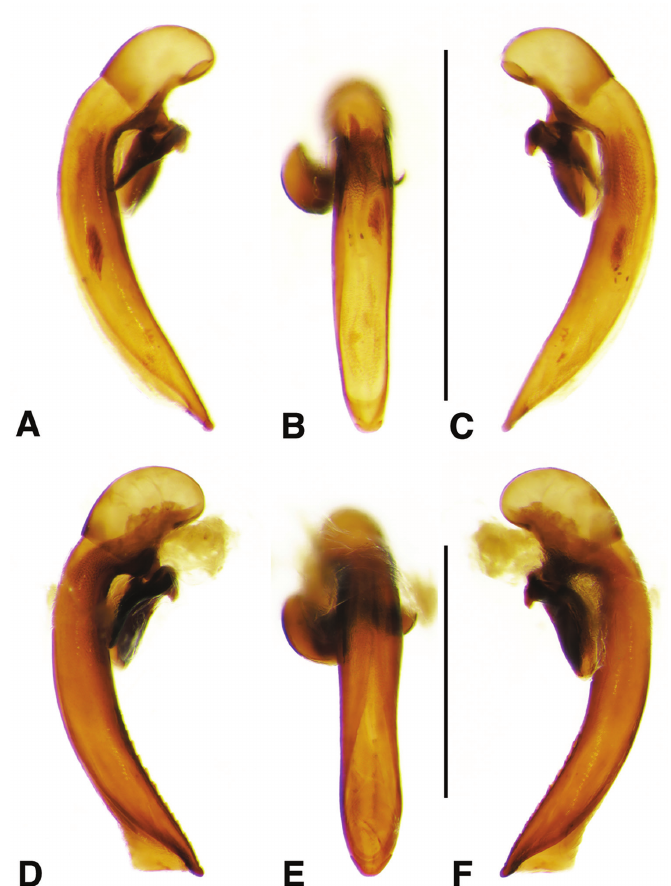
Figure 28. Digital images of male genitalia of Selenophorus hylacis species group, in part. A, D right lateral aspect B, E dorsal aspect C, F left lateral aspect A–C S. parvus Darlington D–F S. subquadratus (Putzeys). Scale bars 1